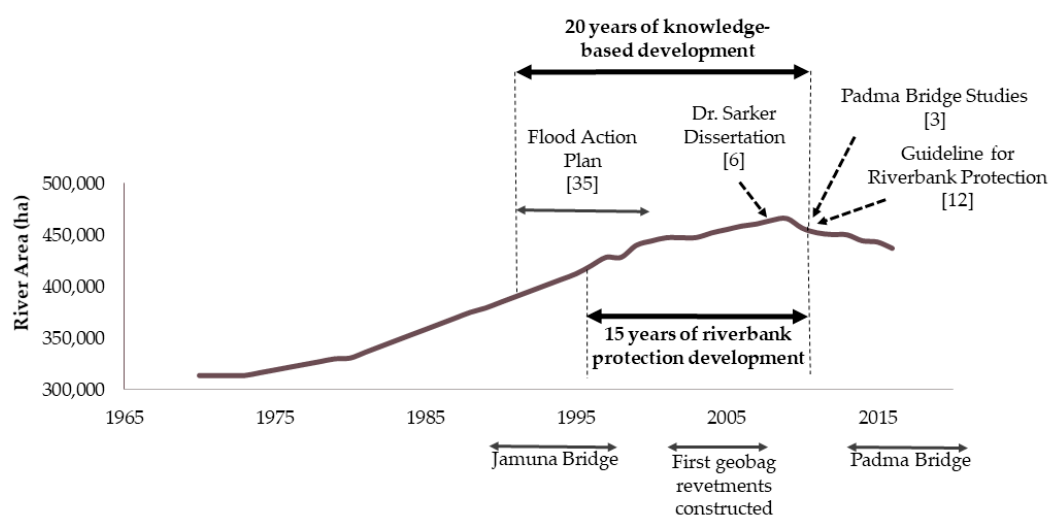
Figure 11. Knowledge-based development in Bangladesh.